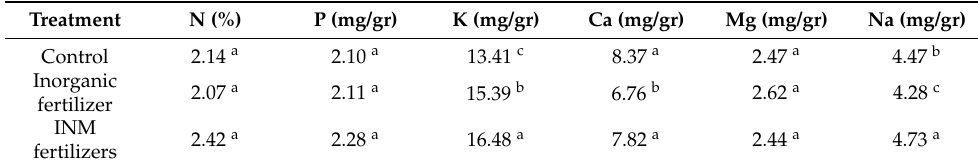
Table 4. Macronutrient concentration of Teucrium luteum subsp. gabesianum young plants treated with inorganic and integrated nutrient management (INM) fertilizers (control: no fertilization).